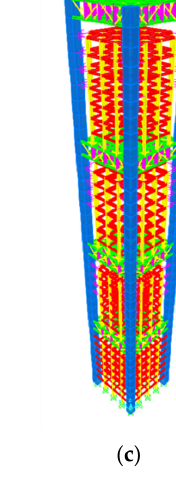
Figure 9. Finite element model of MFVCS. ( a ) Elevation View. ( b ) Plan View. ( c ) 3D View. Table 4. Modal analysis results.